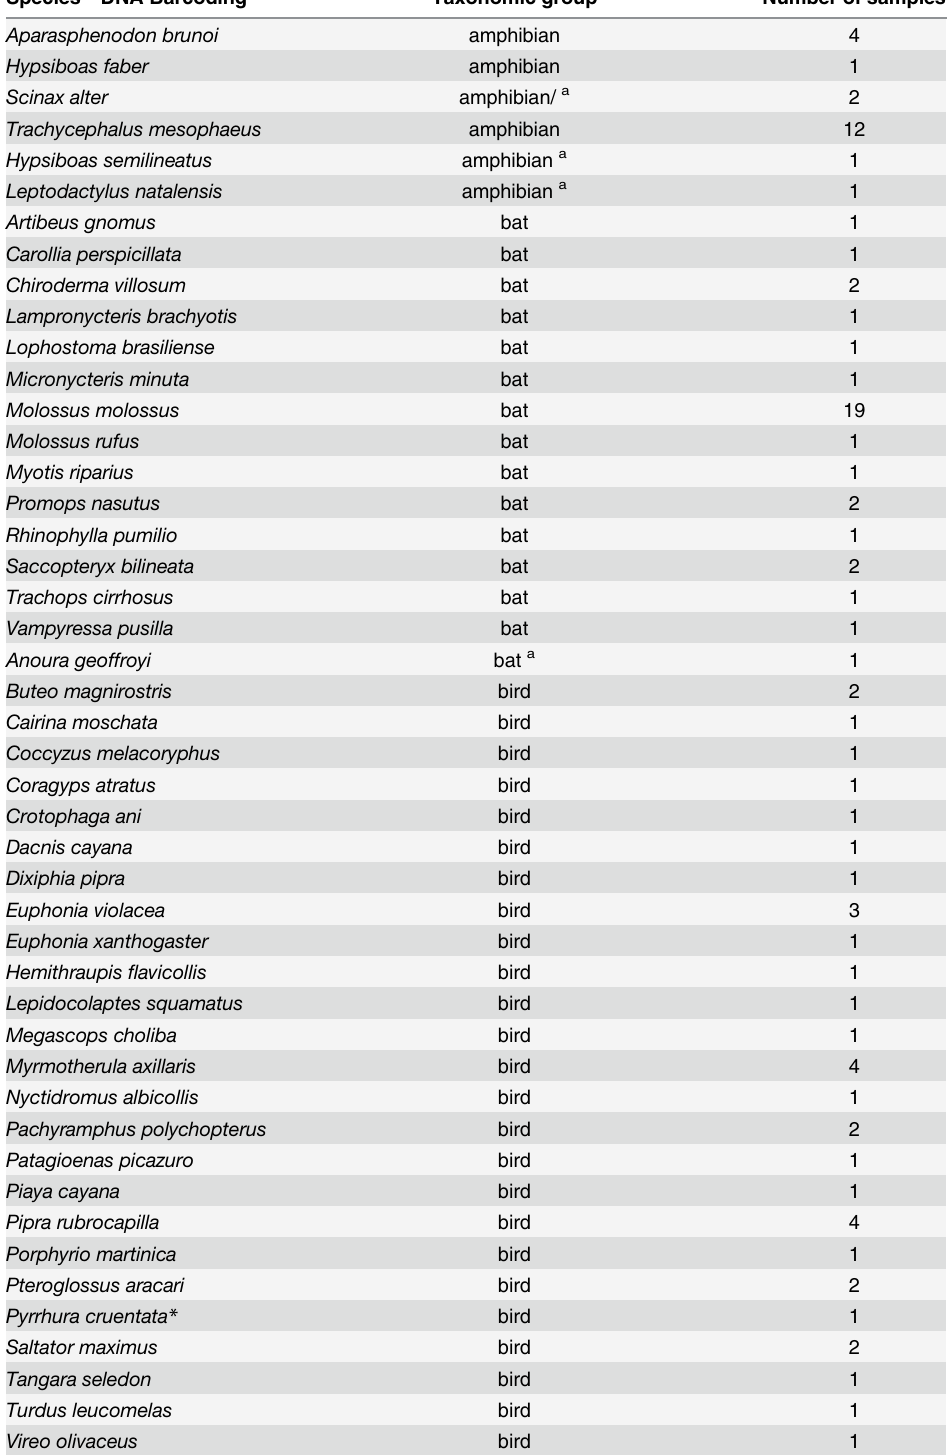
Table 3. List of species, taxonomic group and number of samples identified using only DNA barcod- ing in this study. Species — DNA